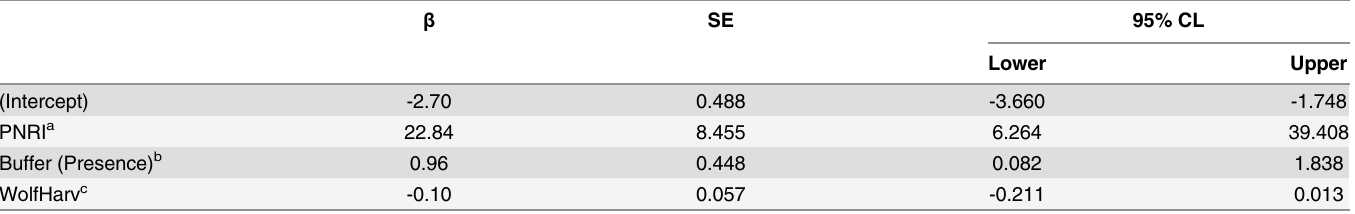
Table 4. Model-averaged parameter estimates for annual probability of sighting model evaluating factors potentially affecting probability of wolf sightings along Denali Park Road in Denali National Park and Preserve,